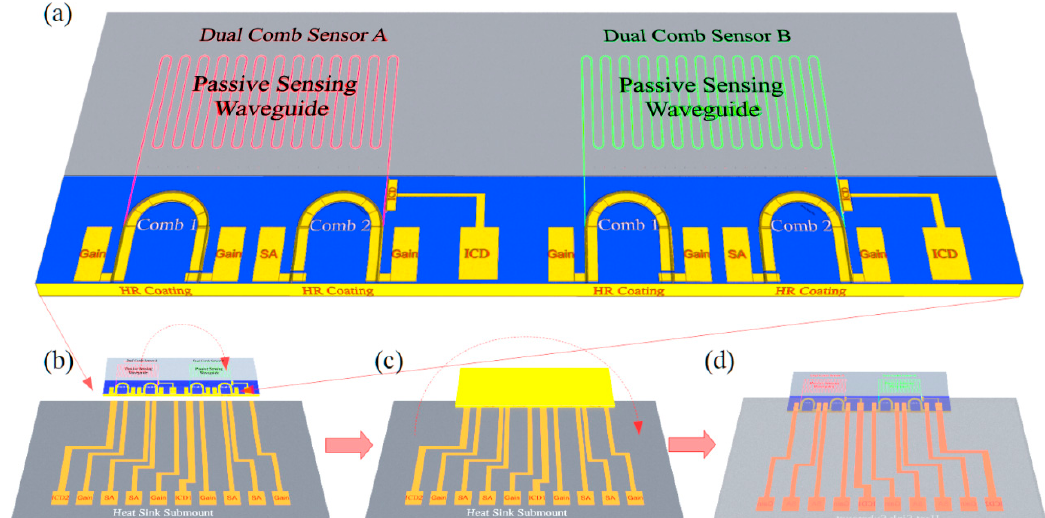
Figure 9. ( a ) Schematic of a PIC that integrates two dual comb spectrometers with multiple ICLs and ICDs grouped at one end and multiple sensing waveguides at opposite end. This allows the lasers to be electro-plated with gold and mounted epitaxial-side-down on a patterned heat sink submount, while the sensing waveguides hang over the edge of the submount to provide exposure to the ambient sample gas; ( b ) The chip and patterned submount before flip-chip bonding ( c ) The chip and submount after flip-chip bonding; ( d ) The reverse side of the flip-chip-bonded PIC, showing the exposed sensing waveguides.